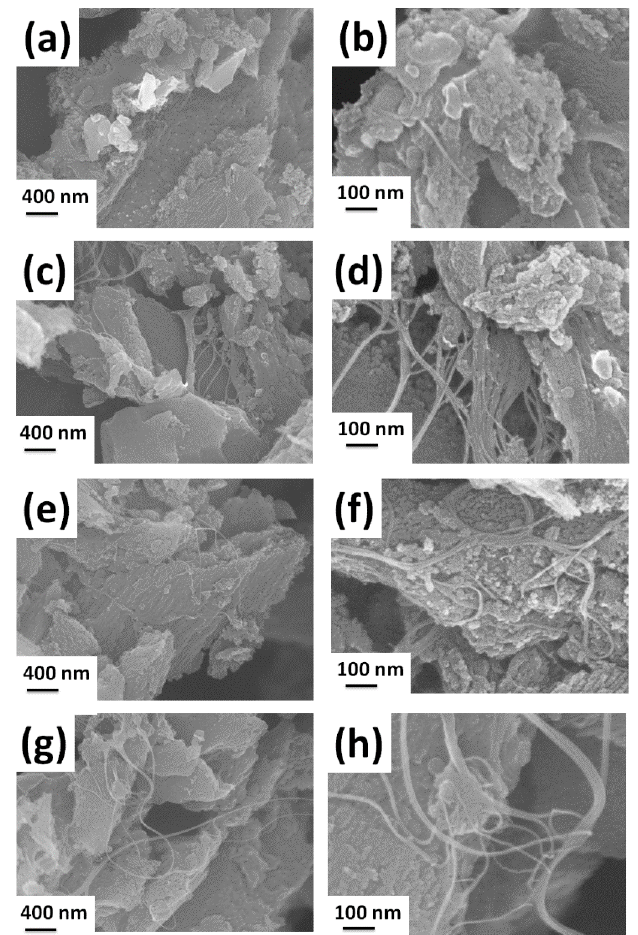
Figure 2. Surface morphology of the fabricated freestanding electrodes with ( a , b ) 5%, ( c , d ) 7.5%, ( e , f ) 10%, and ( g , h ) 12.5% of PVDF concentration.